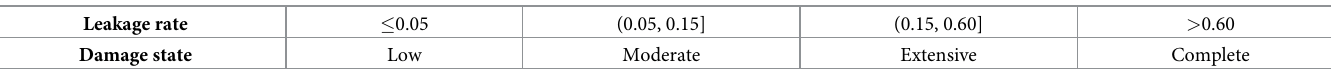
Table 1. Seismic damage classification of the water supply pipeline based on the leakage rate. Leakage